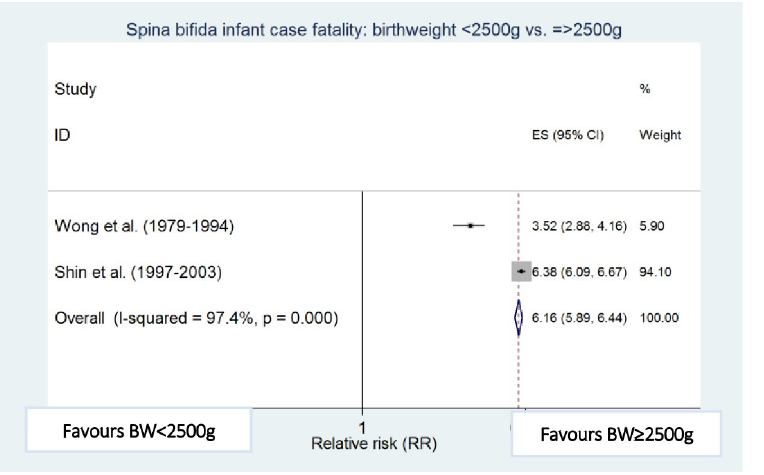
Fig 8. Birthweight. Spina bifida infant case fatality risk factors.